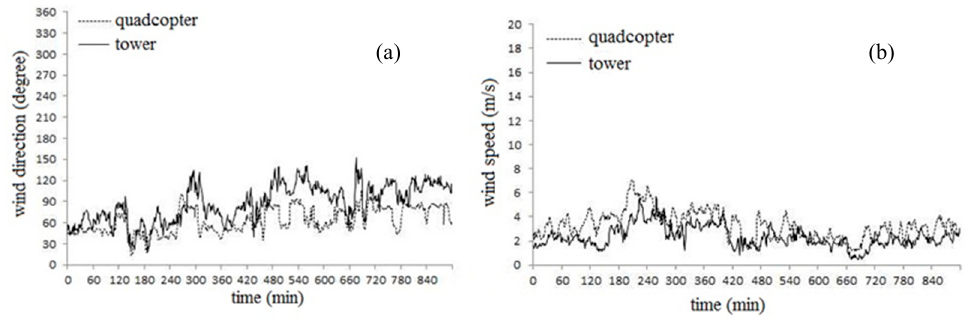
Figure 12. Boundary layer meteorological observation test compared in the height 70 m between our wind sensor on a quadcopter and traditional wind sensor in a tower, ( a ) wind direction and ( b ) wind speed.